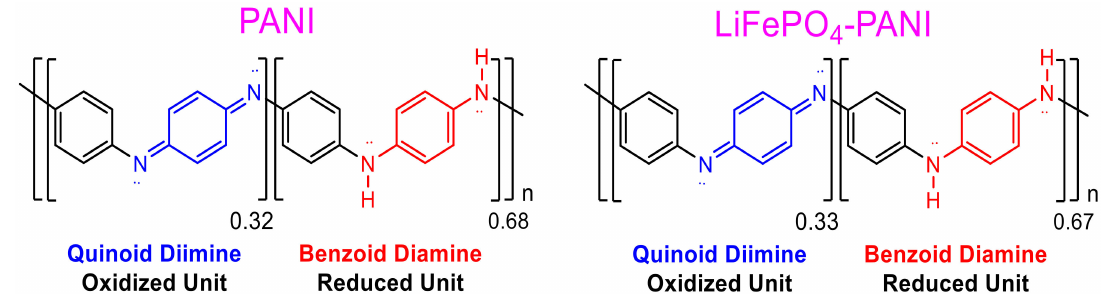
Figure 12. Oxidized and reduced units of PANI and LiFePO 4